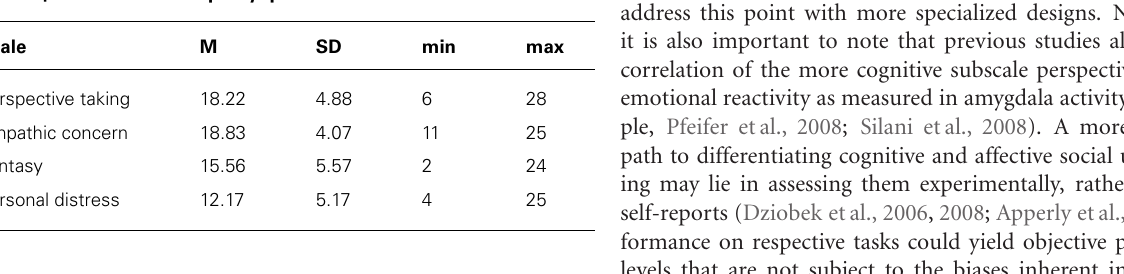
Table 2 | Scores on the empathy